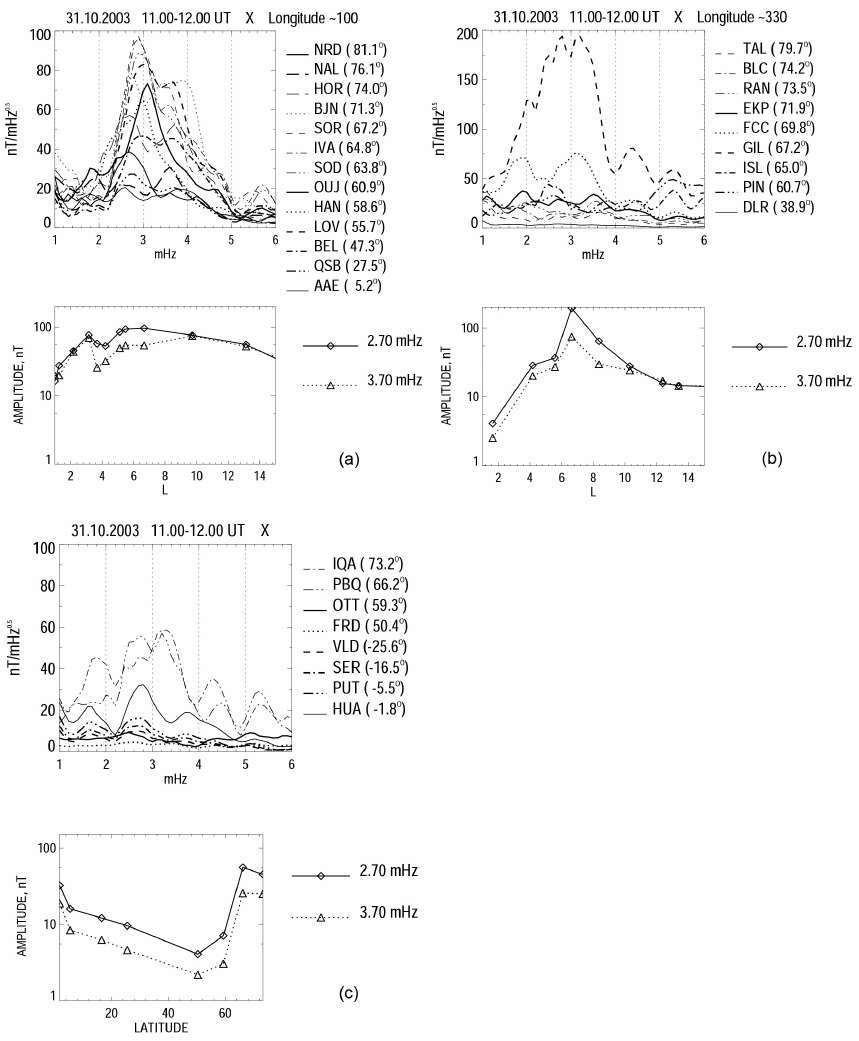
Fig. 5. The latitudinal distribution of Pc5 pulsation ( H component) amplitude and phase on 31 October, 11:00–12:00UT, along the latitudinal profiles: (a) 110 ◦ , (b) 330 ◦ , and (c) 360 ◦ . Upper panels show amplitude spectra, middle and bottom panels show the latitudinal dependence of spectral amplitudes and phases at selected